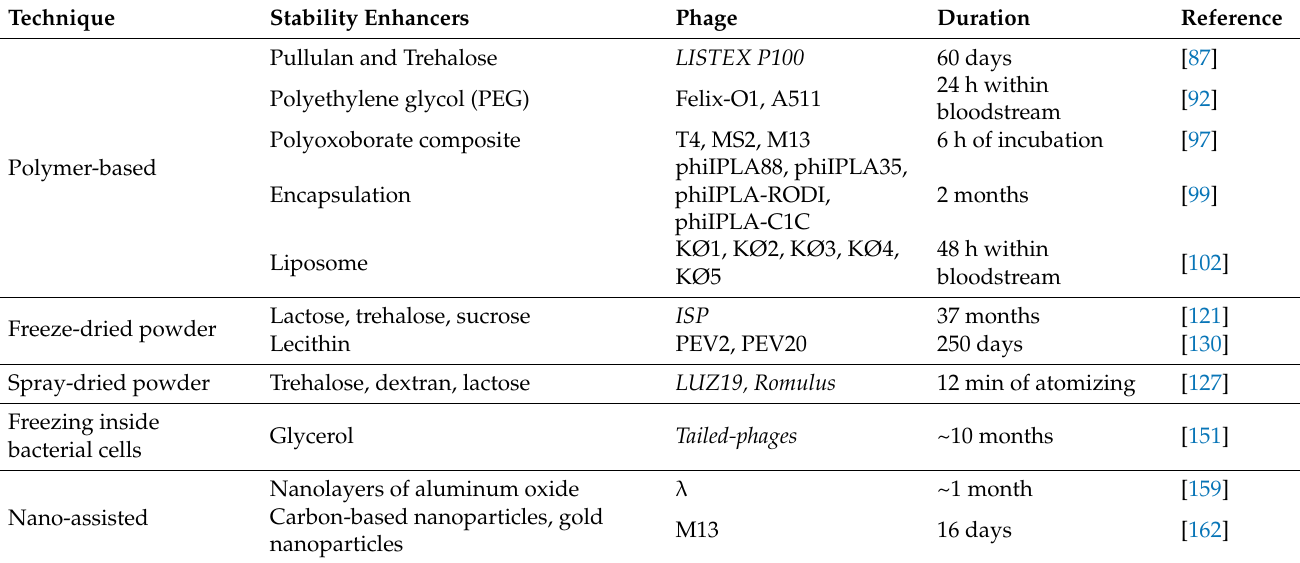
Table 1. Examples of formulations for phage